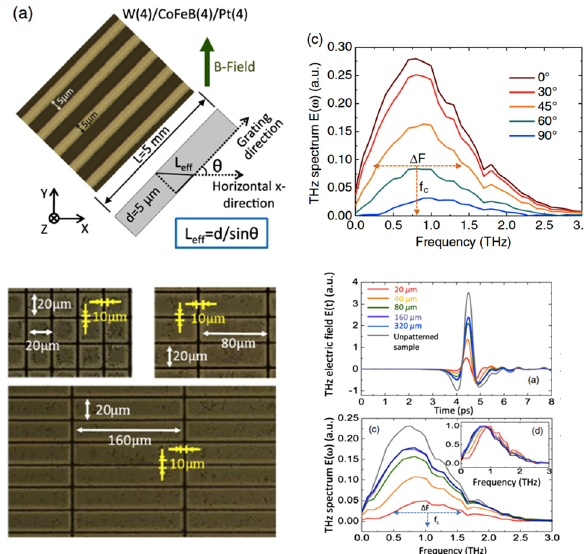
Figure 9: (Upper panel) Illustration of the patterned W/CoFeB/Pt filminstripesof5 μ mwidthandlength.Shiftofthecentralfrequency and changes in the FWHM are observed for different orientations between stripes and external magnetic fi eld. Reproduced from the study by Jin et al. [51] with permission of Wiley-VCH, Copyright 2019. (Lower panel) Blocky patterned CoFeB/Pt with lengths ranging from 20 to 160 μ m. Shaping of the THz spectral amplitude is observed for differentpatterneddimensions.ReproducedfromthestudybySong et al. [52] with permission of The Japan Society of Applied Physics, Copyright